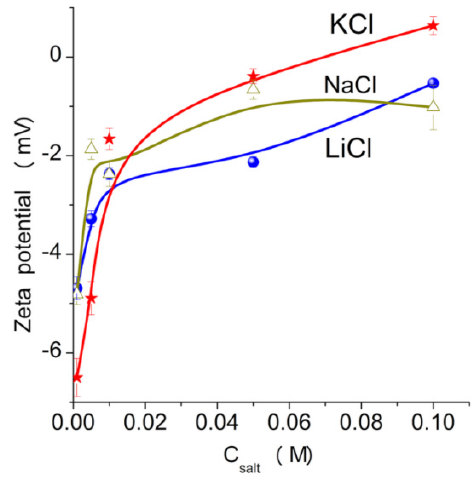
Figure 7. Zeta potential as a function of salt content at C = 5 wt.%. A-200